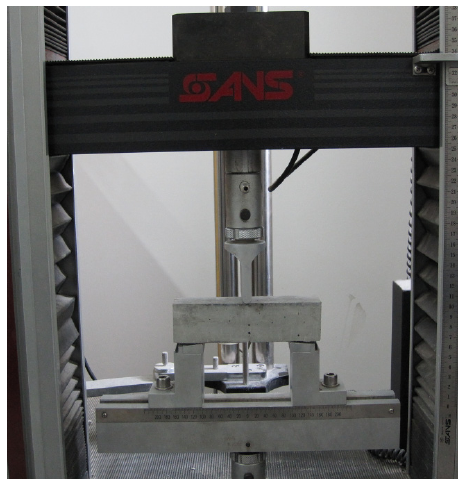
Figure 5. Three ‐ point flexural loading setup. Figure 5. Three-point flexural loading